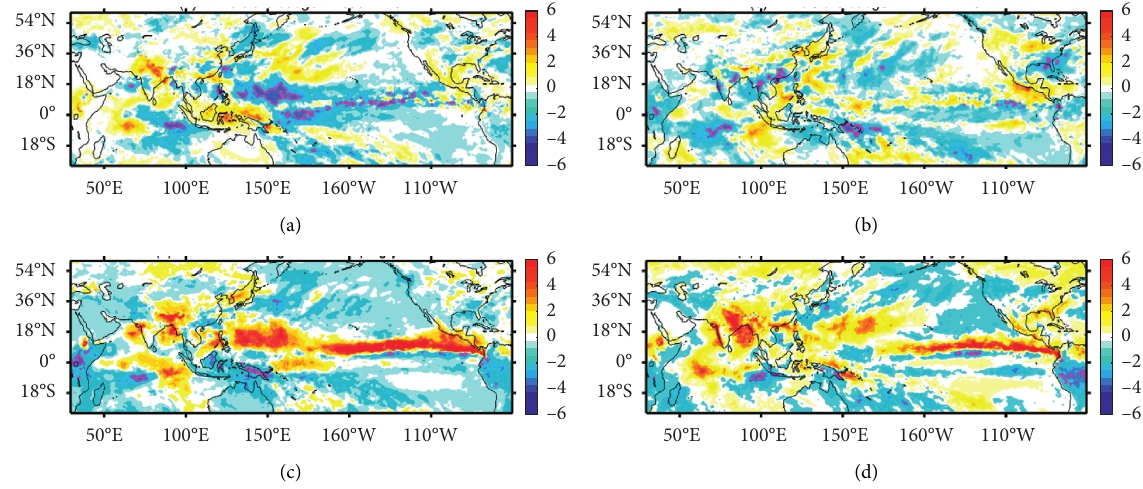
Figure 5: The difference of the moisture budget (units: mm) between the developing and decaying CP El Niño summers (JJA) in the cool (a) and warm (b) PDO phases and between the cool and warm PDO phases in the developing (c) and decaying (d) years. Mauve lines indicate 95% and higher confidence levels using t -test.